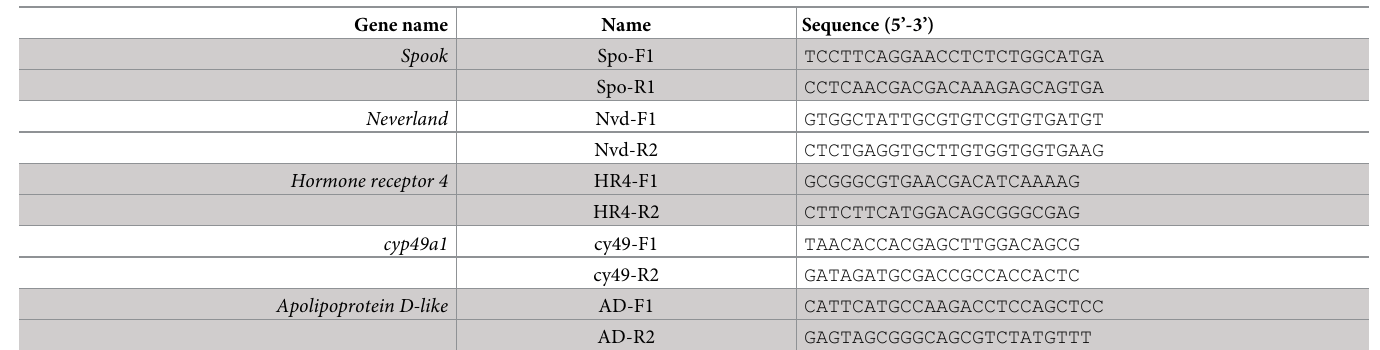
Table 1. List of primers that were used for the tissue distribution in C . sapidus